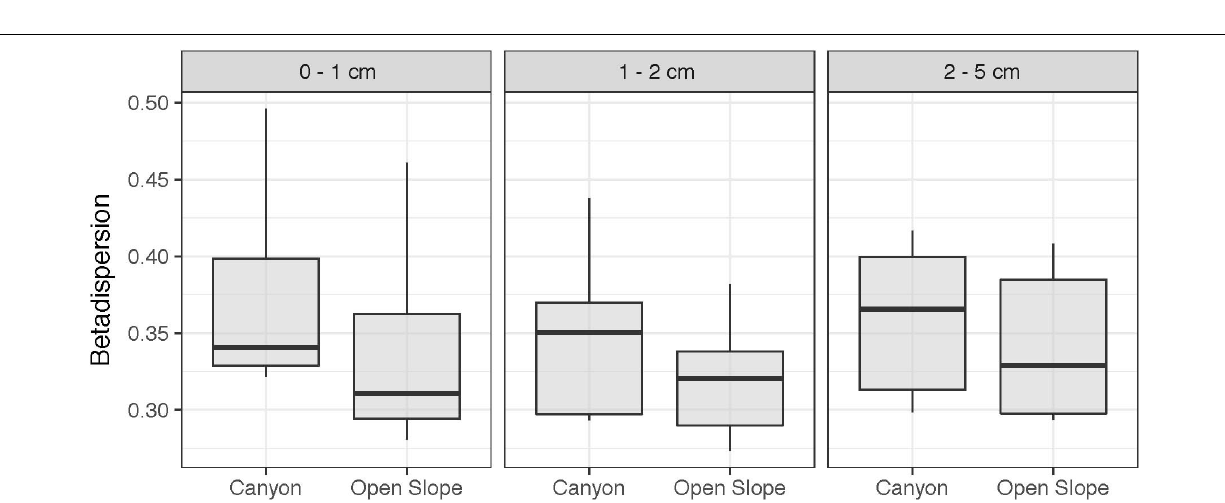
Frontiers in Marine Science |